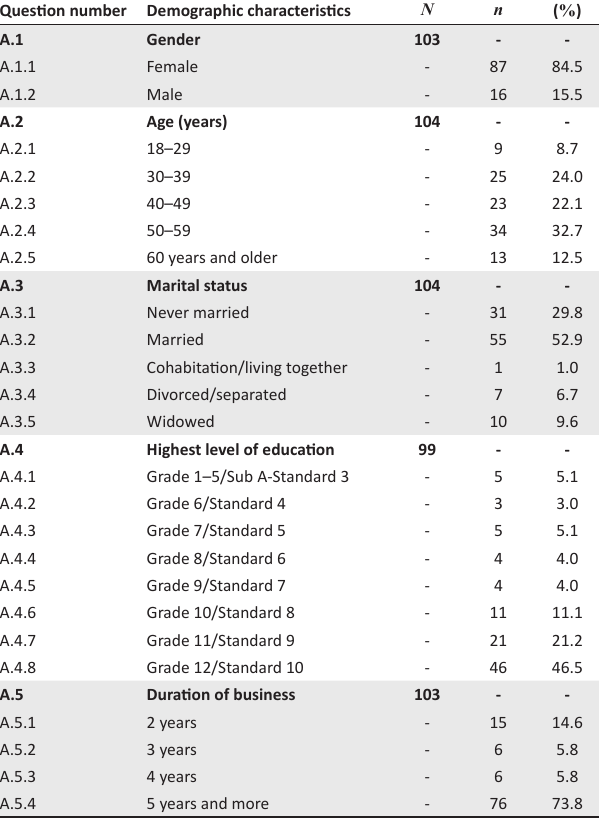
TABLE 1: Demographic characteristics of